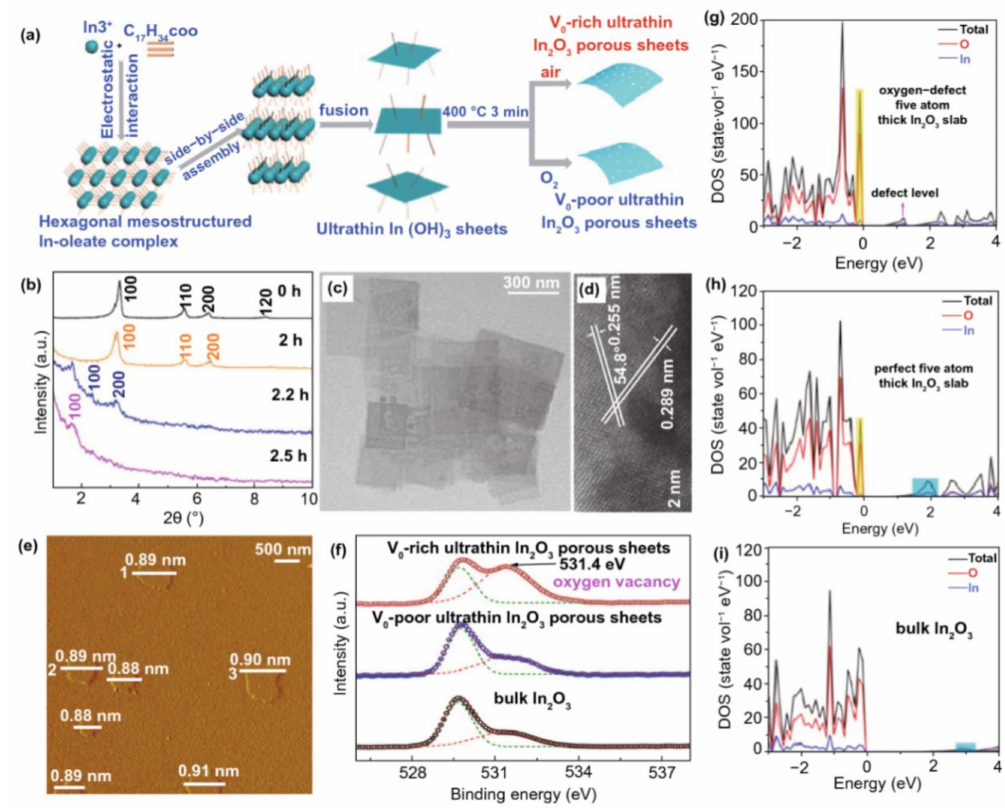
Figure 2. ( a ) Atomically thin In 2 O 3 porous nanostructures with mixed V O concentrations under specific conditions; ( b ) display of time-dependent small-angle X-ray diffraction patterns for an as- prepared precursor; ( c – f ) characterization of V O -rich atomically thin, porous In 2 O 3 nanostructures generated by air-based, rapid thermal heating of In(OH) 3 nanostructures; ( c , d ) demonstration of TEM/HR-TEM Photograph; ( e ) visualization of AFM investigation; ( f ) O 1s XPS spectra; ( g ) electron spins resonance spectrum; ( h ) simulated density of state (DOS) of an In 2 O 3 slab with an O defect which is five atoms thick; ( i ) perfect In 2 O 3 slab with a five-atom thickness. Adapted from [53] Copyright 2014, American Chemical